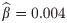
Kernel (a) and Cox (b, β^=0.004, p-value = 0.696) estimate of conditional hazard function with age as a covariate.